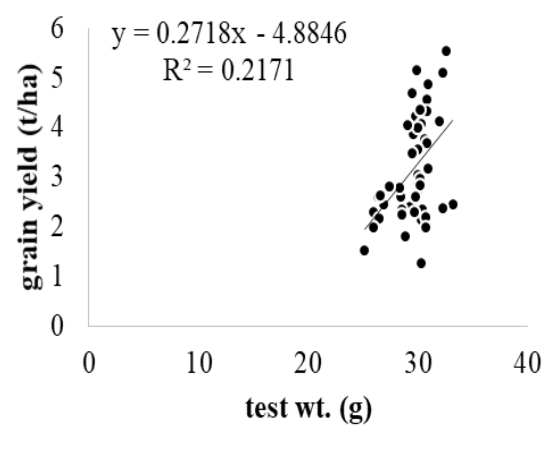
Figure 1: Scattered plot of grain yield vs test